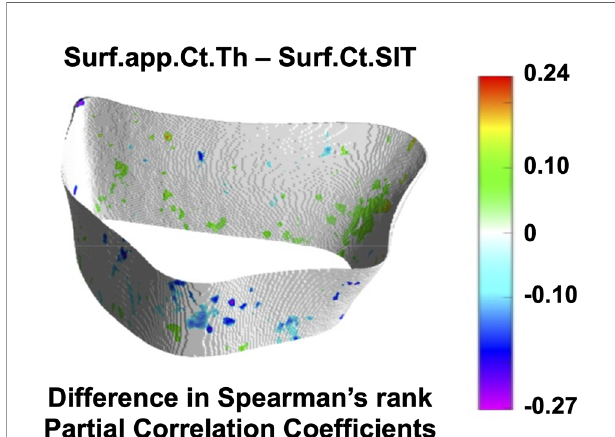
FIGURE 6 | Assessment of spatial differences of interrelationships of cortical bone parameters between controls and fracture cases. Surface statistical map showing vertices for which the Spearman ’ s rank partial correlation coef fi cients were signi fi cantly different between controls and fracture cases for the interrelationship of Surf.app.Ct.Th – Surf.Ct.SIT. Signi fi cant vertices are showing the difference of correlation coef fi cients (fracture cases minus controls) with nonsigni fi cant vertices displayed in white. Surf.app.Ct.Th – Surf.Ct.SIT was the only cortical bone interrelationship that showed signi fi cant spatial differences between controls and fracture cases.